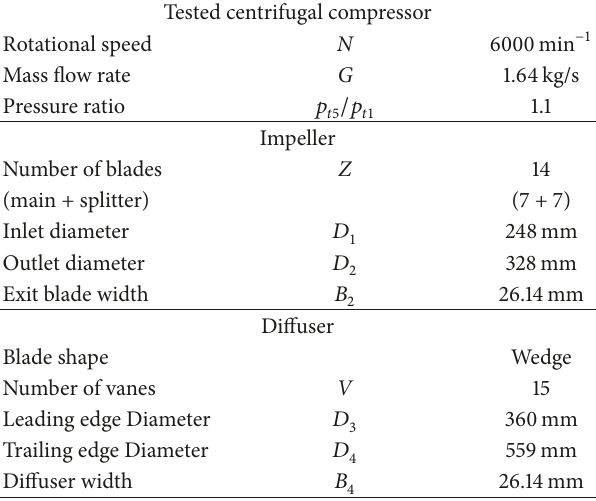
Table 1: Dimensions of tested